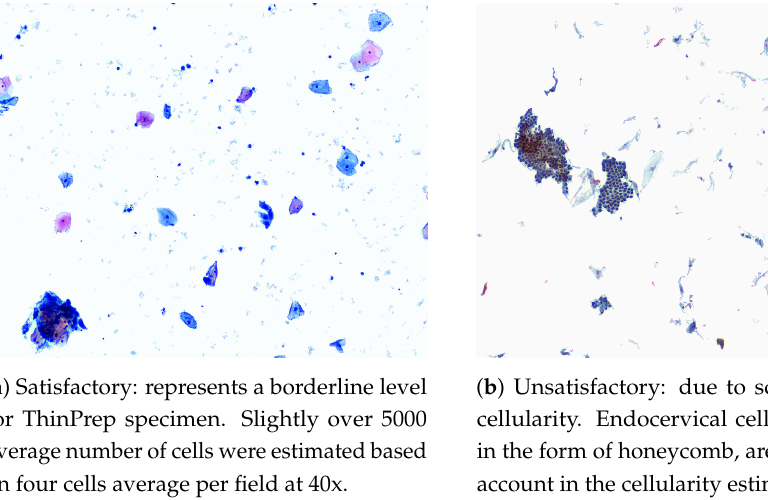
Figure 1. Satisfactory ( a ) and unsatisfactory ( b ) LBC preparations. From: Nayar, R.; Wilbur, D. The Bethesda System for Reporting Cervical Cytology: Definitions, Criteria, and Explanatory Notes, 3rd ed.; Springer International Publishing, 2015 [26] and reproduced with permission of